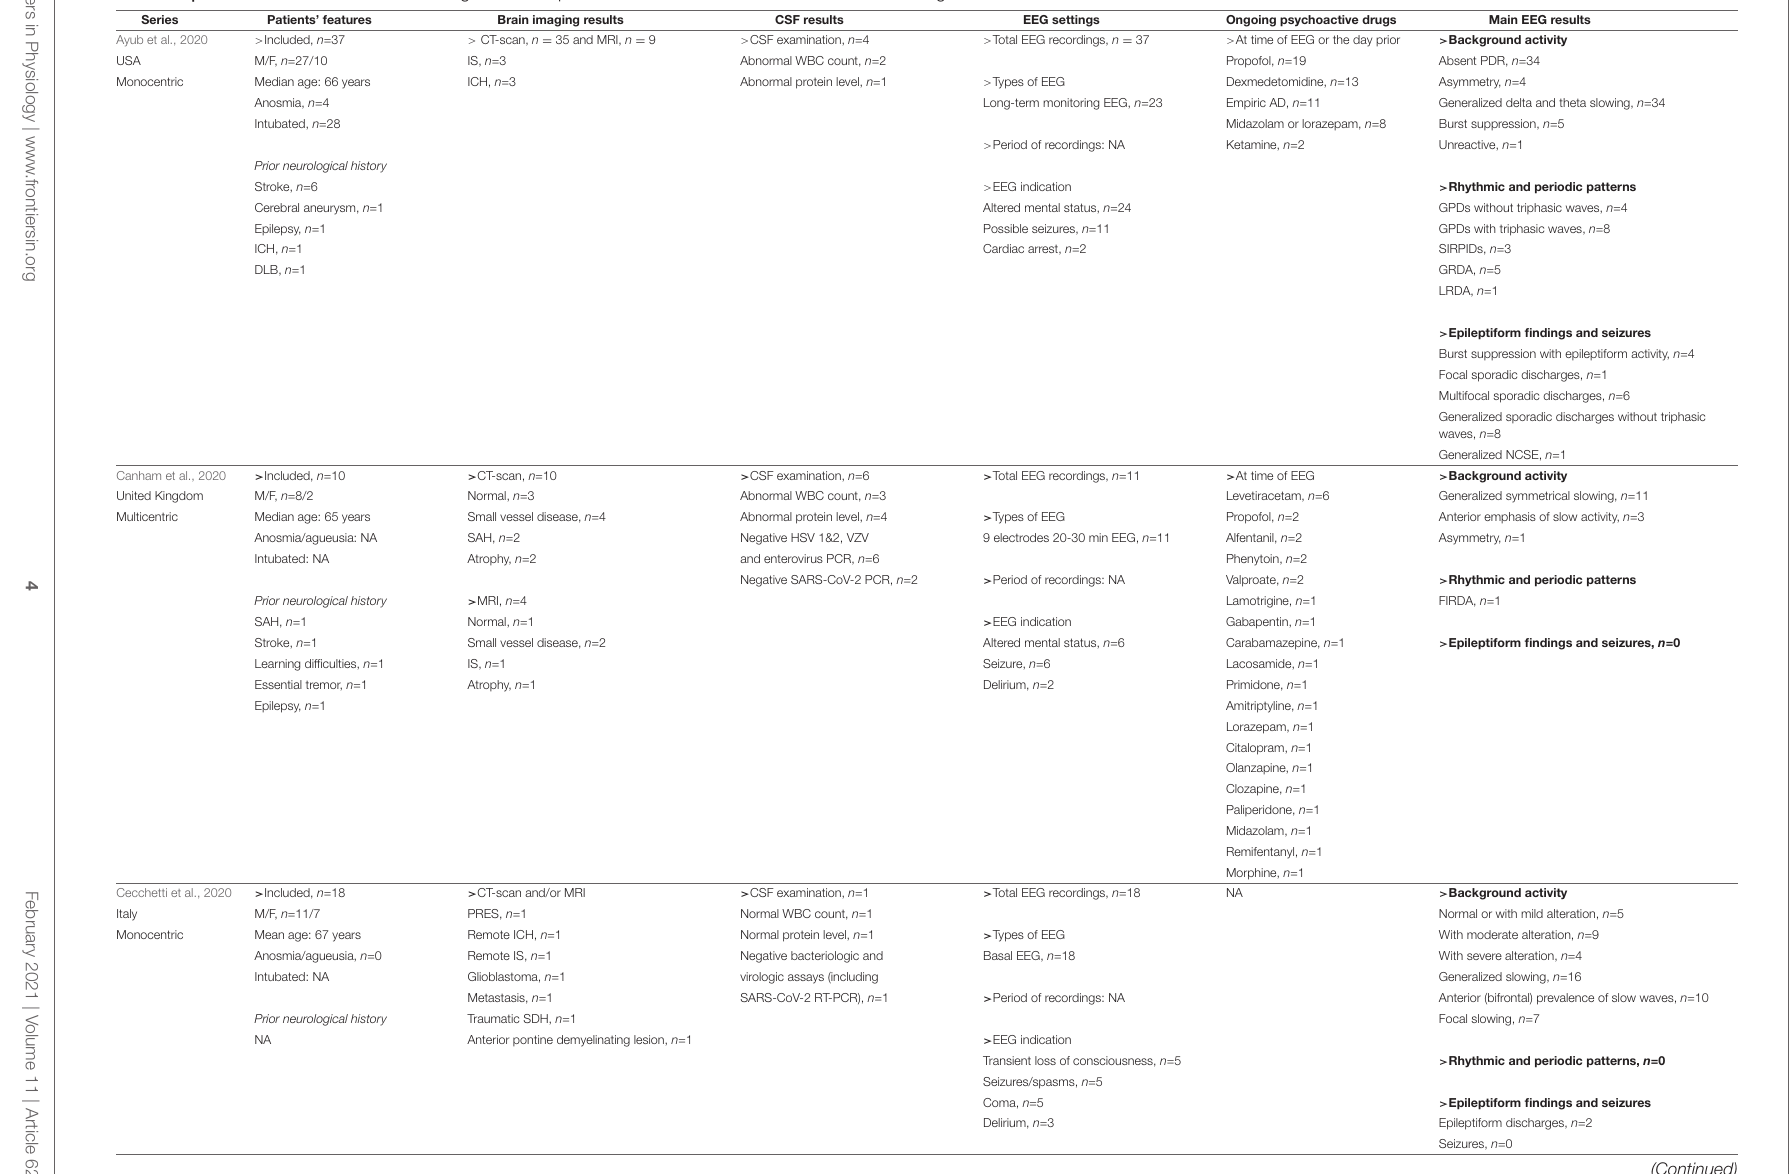
TABLE 1 | Main results of case series including at least 10 patients admitted for COVID-19 with EEG